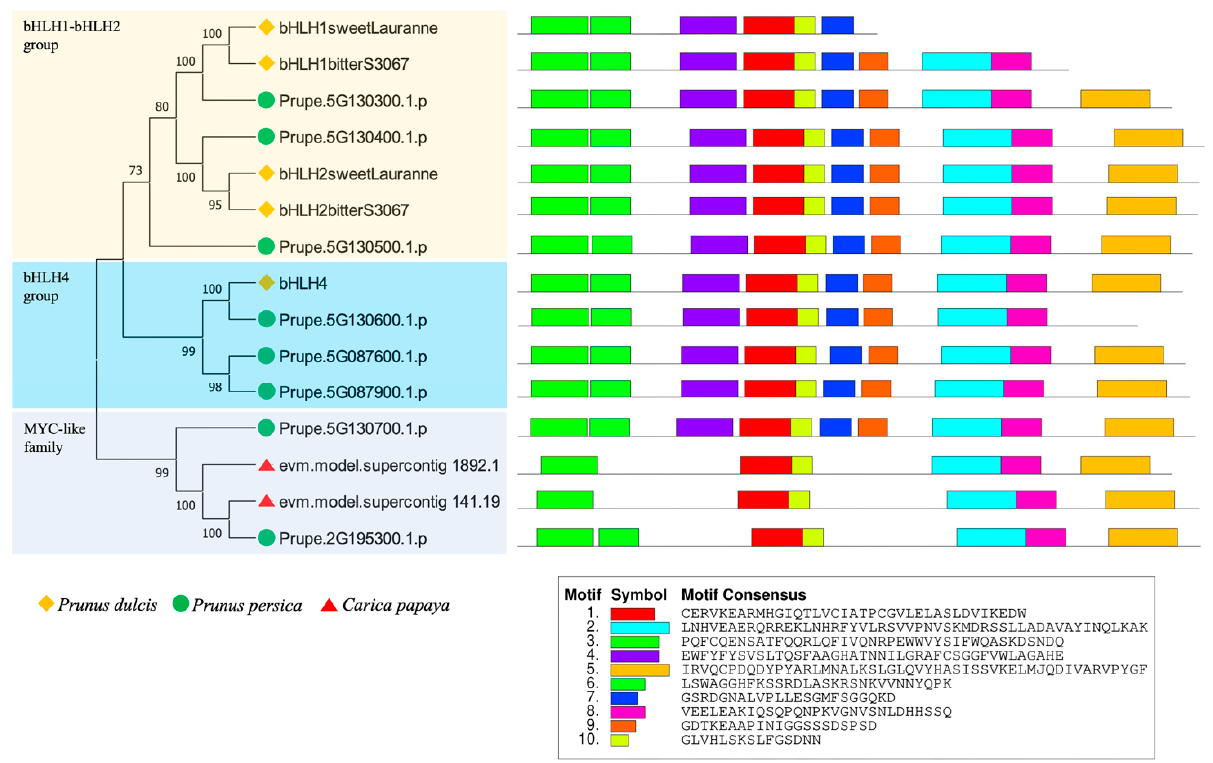
Figure 6. Phylogenetic relationship of bHLH genes encoding transcription factors and their corre- sponding motif structures in P. dulcis , P. persica , and papaya using full-length protein sequences of 15 identified bHLH genes.